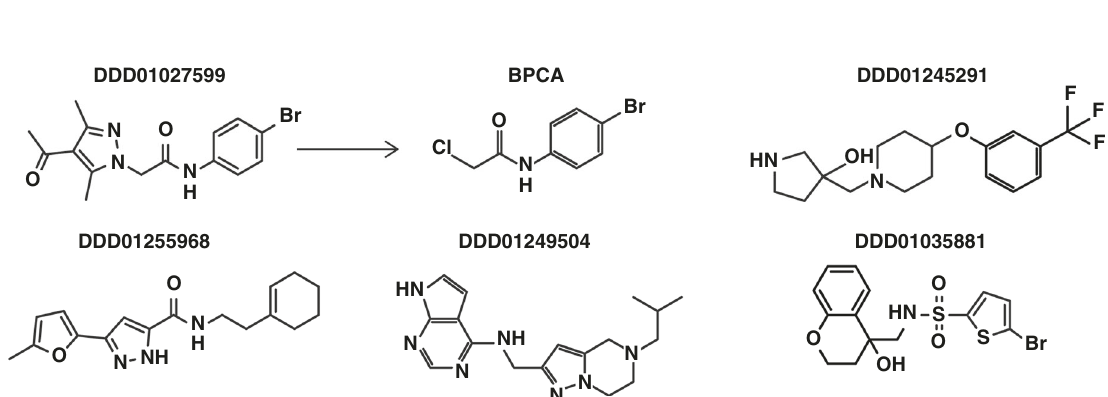
Fig. 3 Chemical structure of GHCDL compounds selected for further study. Five compounds showing a range of transmission-blocking activity at the pro fi ling stage were selected for detailed study. DDD01027599 (found to actually be BPCA — see Supplementary Fig. 1-2) and DDD01245291 are active against gametocytes and asexuals; DDD01255968 and DDD01249504 are active speci fi cally against male gametocytes; and DDD01035881 speci fi cally